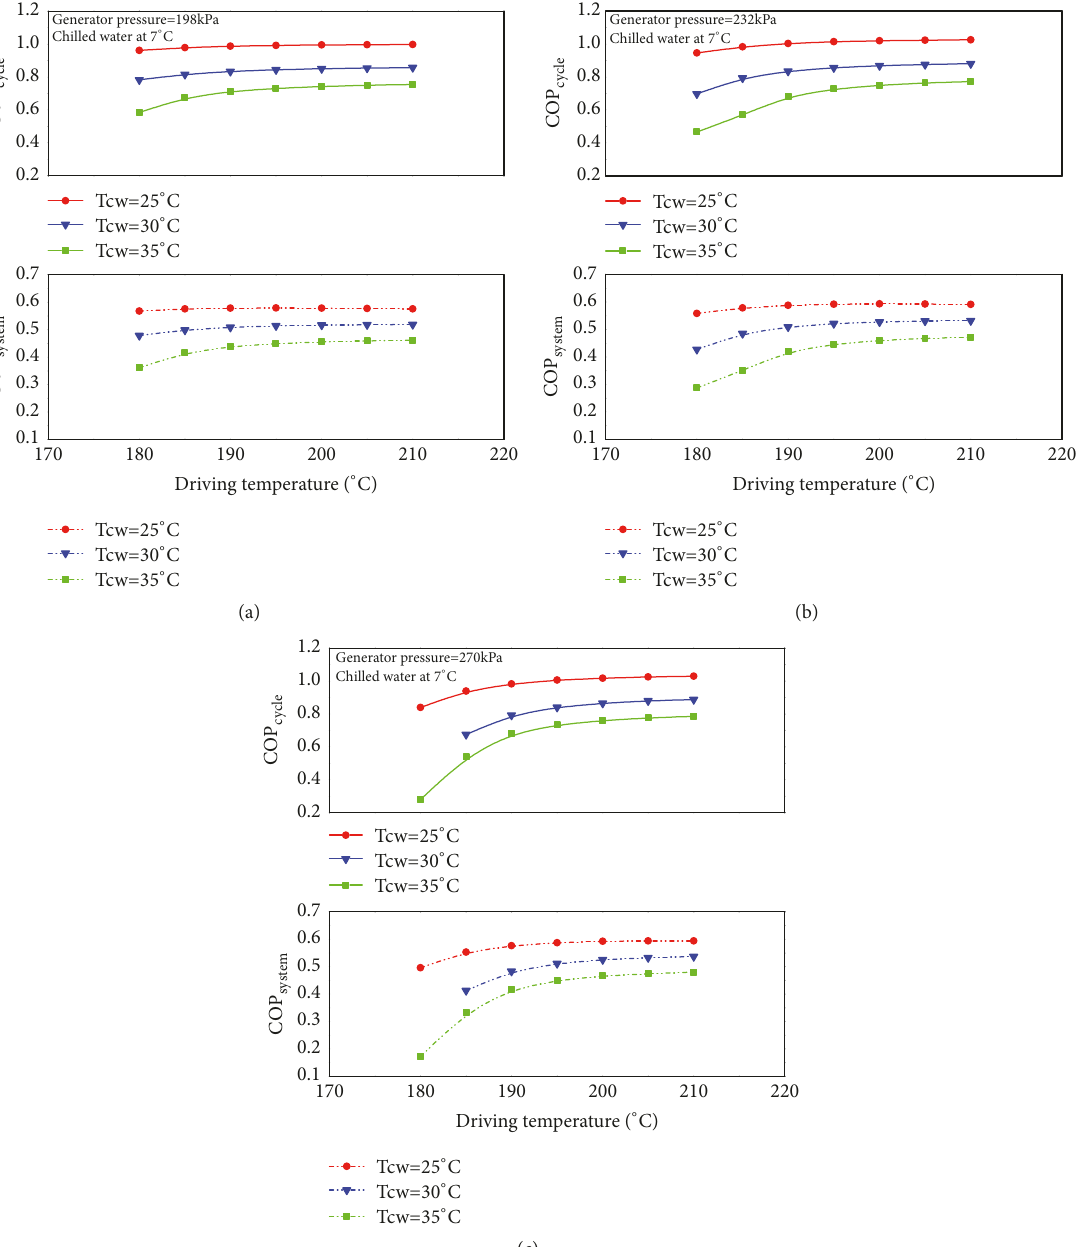
Figure 5: Effect of generator temperature on system performance for different generator pressures and cooling medium temperatures.